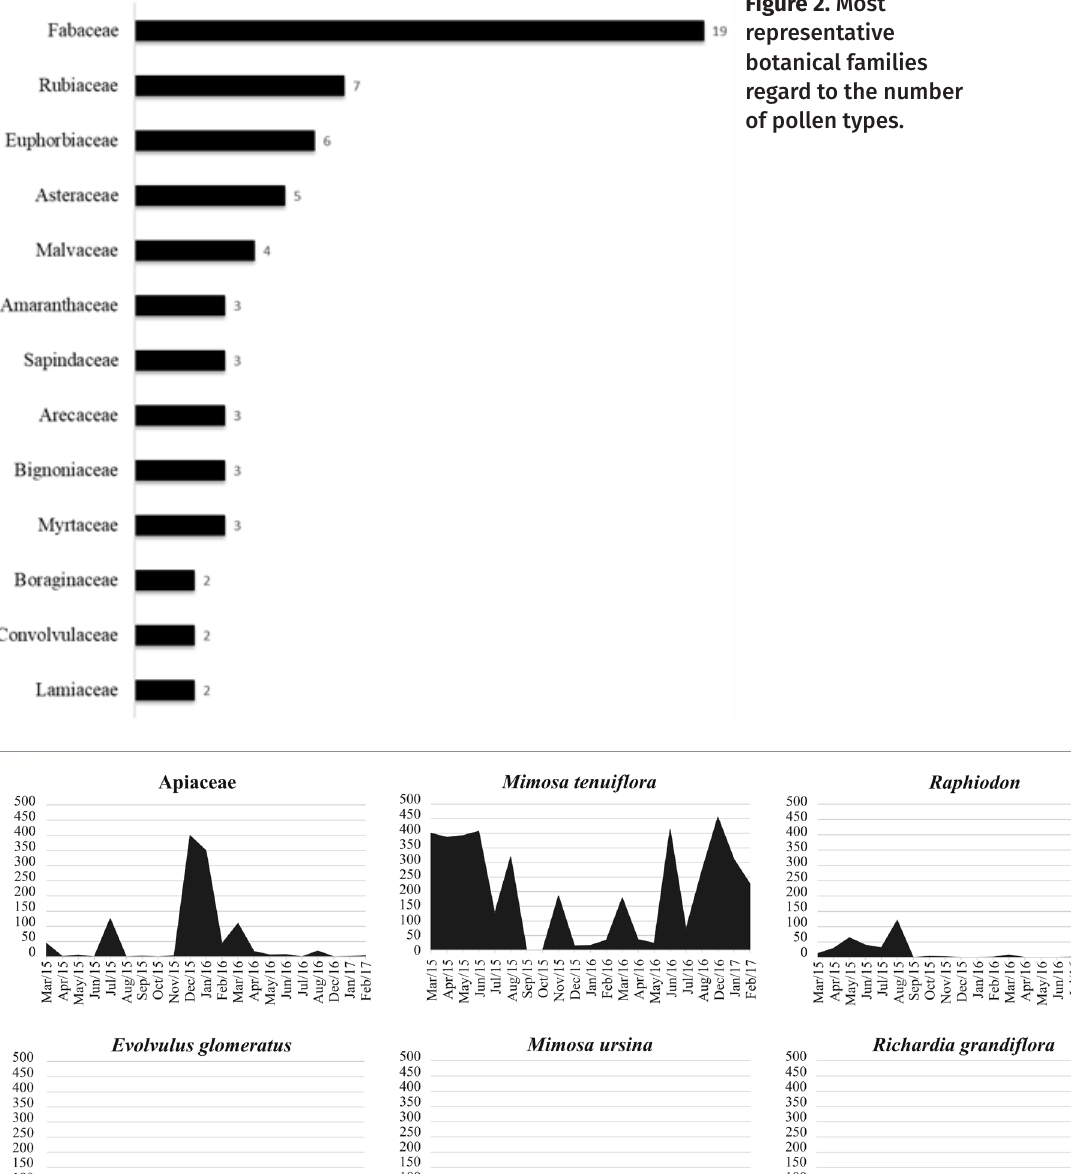
Figure 2. Most representative